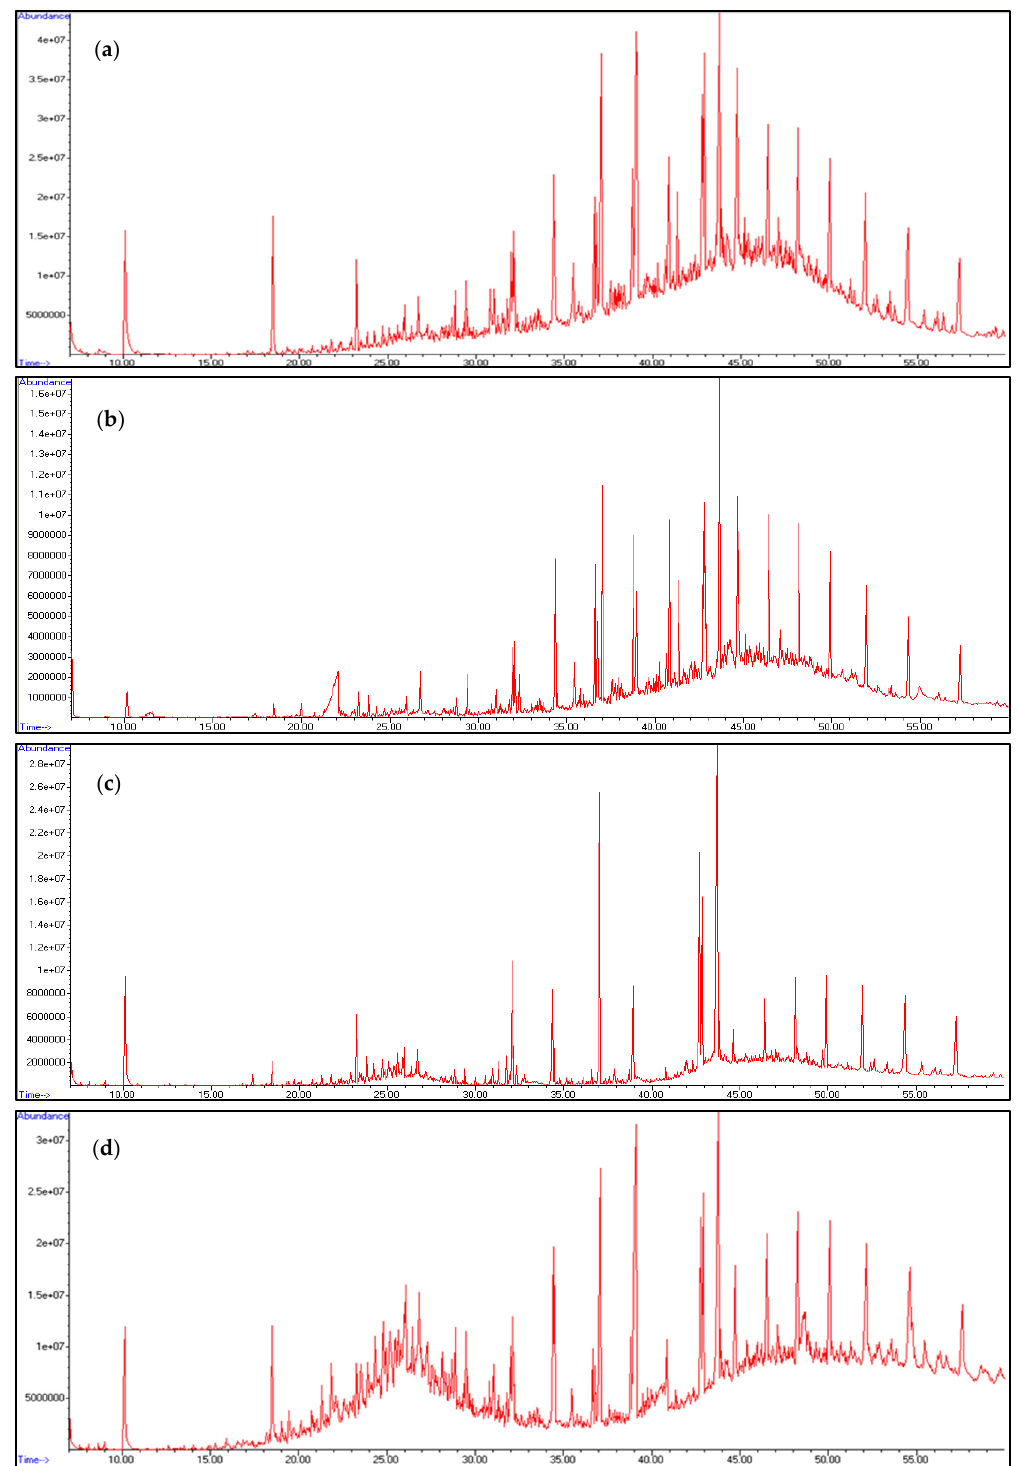
Figure 5. Chromatographic analysis by GC-MS of: ( a ) real untreated BW and after 7 days treatment with ( b ) Citrobacter sp . D2, ( c ) Halomonas sp. Hal-CG, ( d ) Exiguobacterium sp. Ex-Ind2 . X axis: Time (min); Y axis: Abundance.